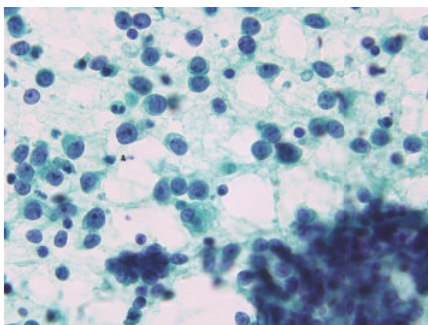
Figure 1: Papanicolaou-stained smear showing a high cellularity with loosely cohesive cells or isolated cells. The cells were 2–2.5 times greater in diameter than that of a small lymphocyte. The nuclei were round to oval in shape with slightly irregular contours and contained one or more prominent nucleoli. The chromatin was hyperchromatic and finely granular.